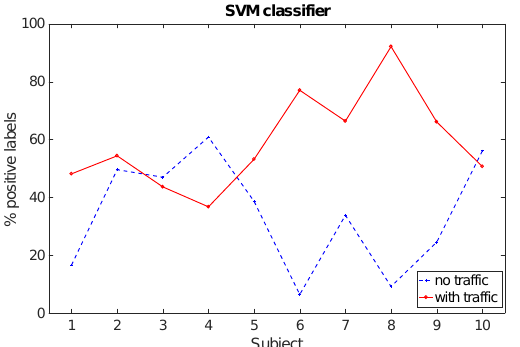
Figure 8. Total number of intervals identified as “stress” by the SVM classifier (in %) for each subject in the two different driving situations.